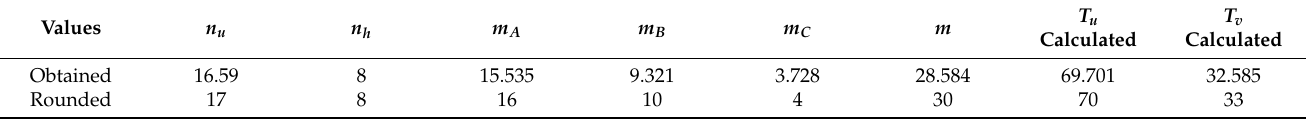
Table 3. Results obtained using formulas for the case without